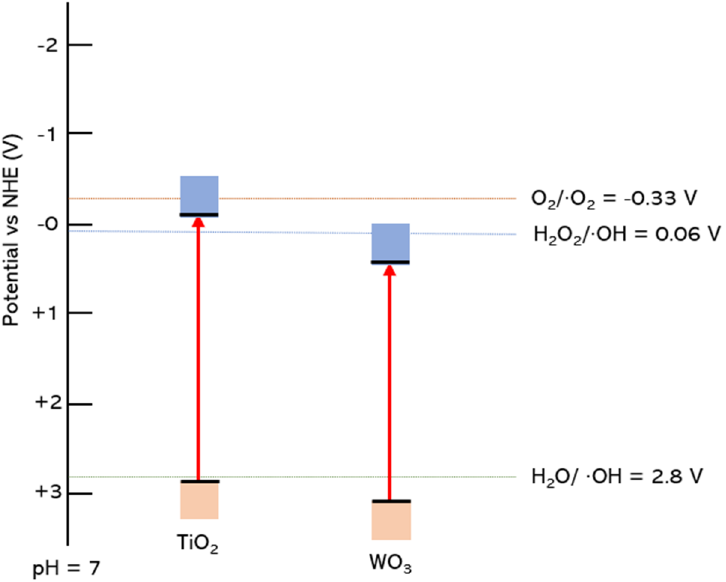
Figure 30. The valence and conduction band of WO 3 and TiO 2 photocatalyst and the potential standard reduction of hydroxyl radical and superoxide radicals.